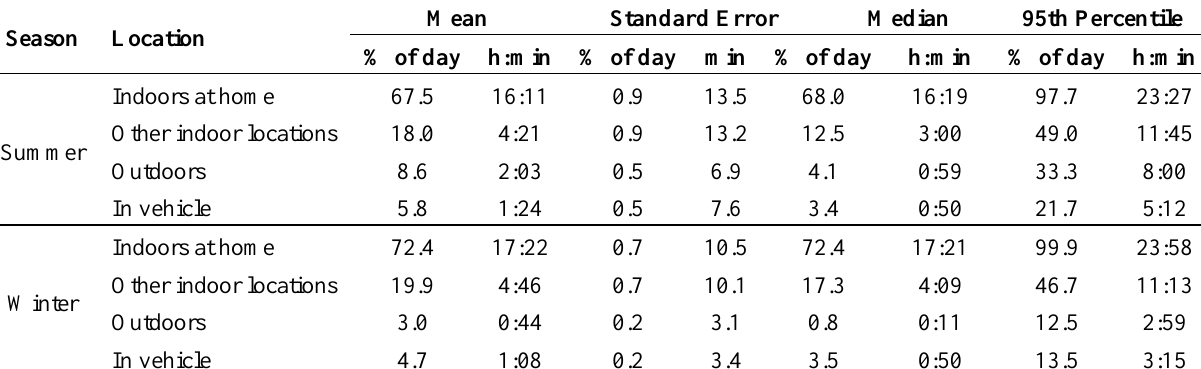
Table 4. Daily time spent in major locations for the population by